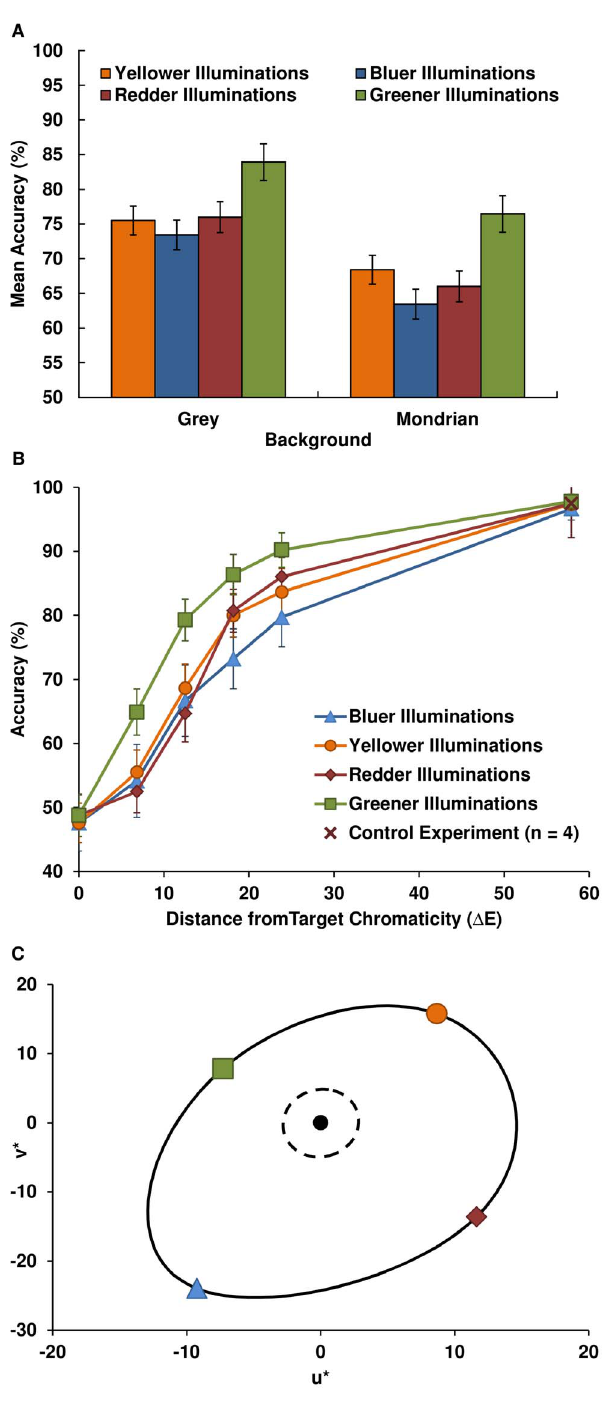
Figure 2. Mean discrimination accuracy for various conditions. A. Mean discrimination accuracy for illuminations by their chromatic direction, for conditions using the grey or Mondrian background; for significant differences see main text. B. Mean accuracy across all conditions and participants for each chromatic direction as a function of perceptual distance from the target chromaticity D E uv . C. Computed D E uv mean thresholds at 75% accuracy for each chromatic direction, plotted in CIE u*v* colour space, with a spline forming the just- noticeable-difference discrimination contour (bold line) from D67 (black marker); just-noticeable-difference MacAdam ellipse boundary for D65 (dashed line) plotted around D67 point.